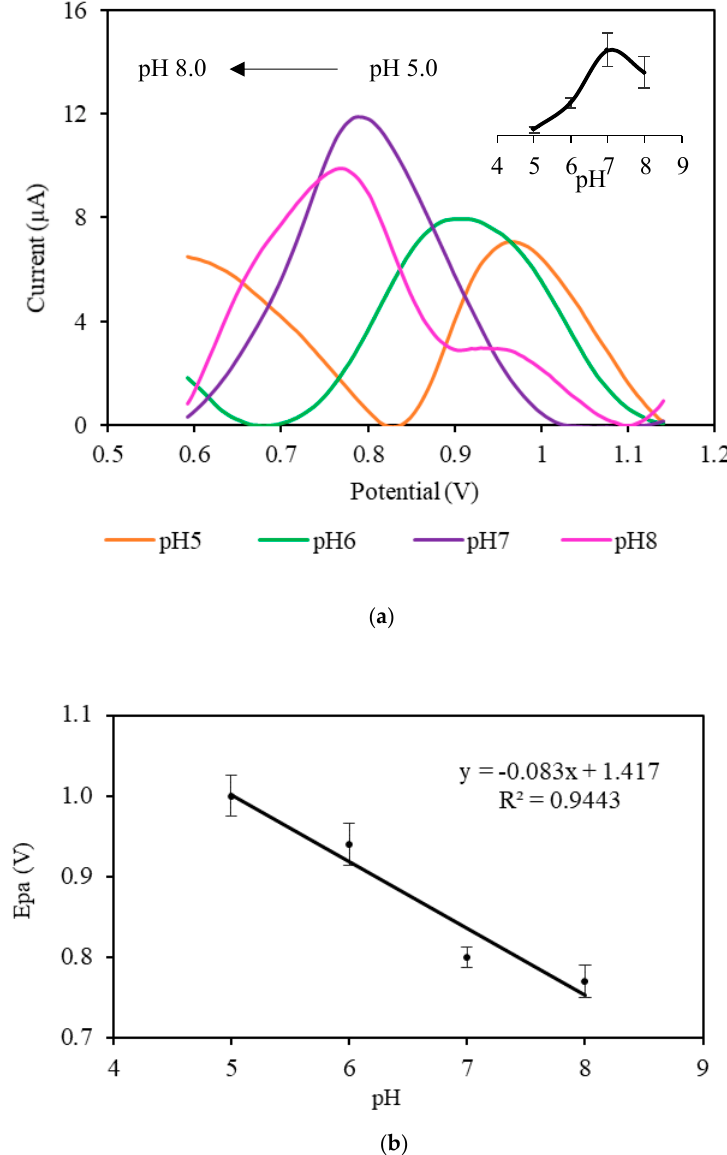
Figure 5. ( a ) Differential phase voltammetry (DPV) voltammograms of CNC – rGO toward 5 × 10 − 3 M Figure 5. ( a ) Di ff erential phase voltammetry (DPV) voltammograms of CNC–rGO toward 5 × 10 −